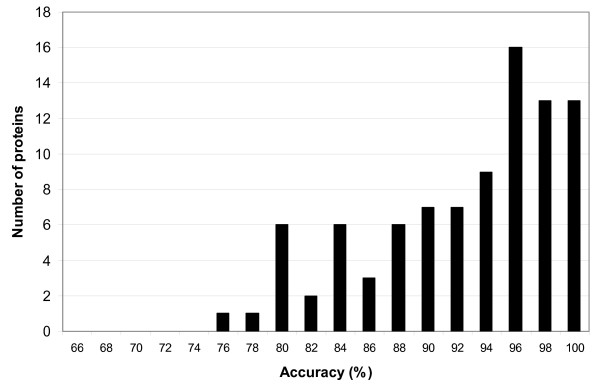
Histogram illustrating the distribution of accuracy (Q3) scores (%) as measured on the test set of 88 proteins that had homologs (E > 10-7) to existing PDB entries. The mean is 90.0% and the standard deviation is 6.3%.